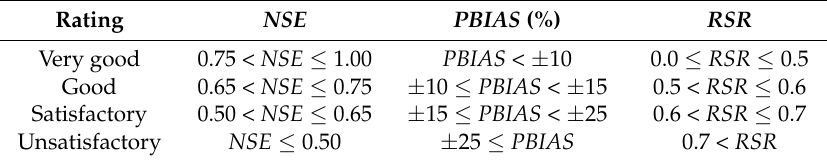
Table 6. Performance rating for monthly time step. NSE = Nash–Sutcliffe efficiency. PBIAS = percent bias. RSR = the ratio of the root mean square error to the standard deviation of measured data.